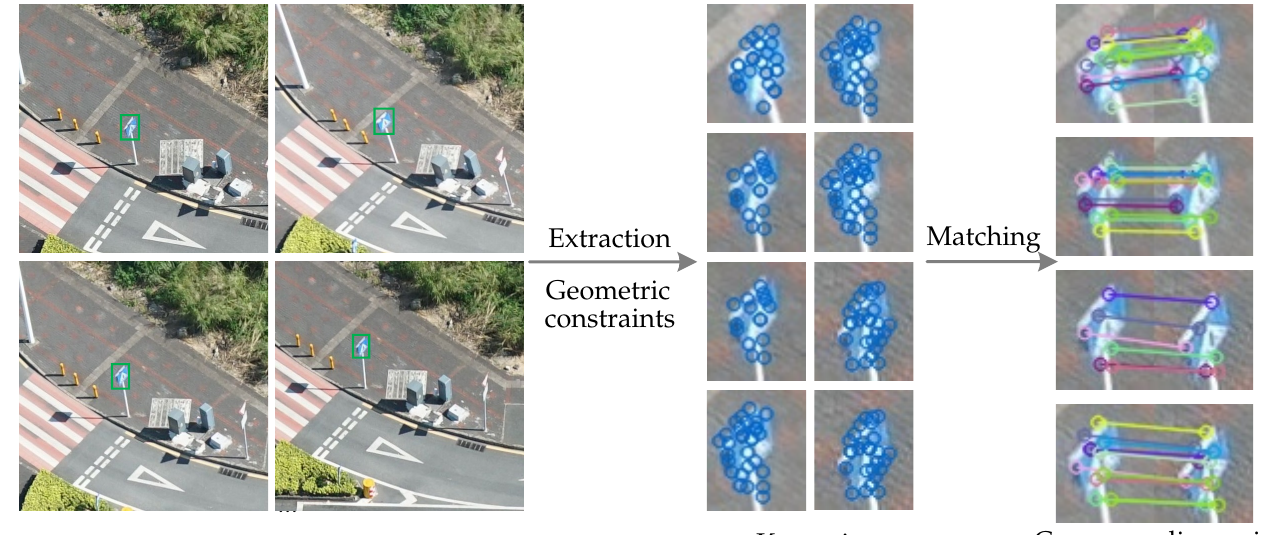
Figure 5. Main steps in corresponding point extraction.